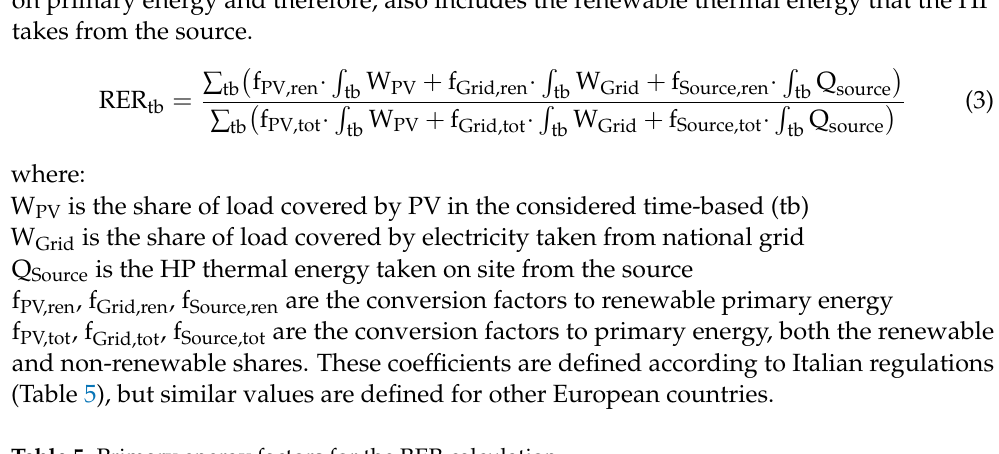
Table 5. Primary energy factors for the RER